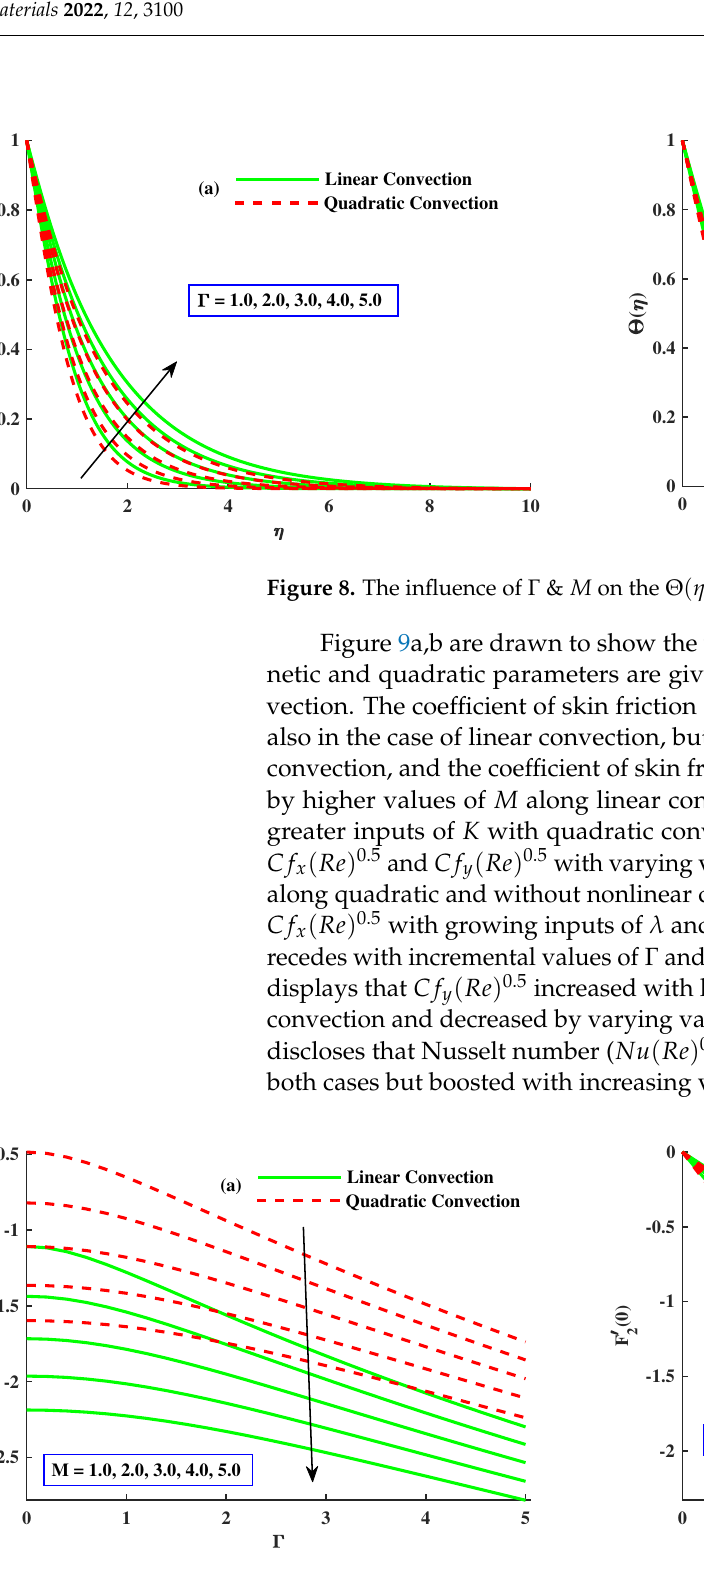
Figure 9. The influence of Γ & M on the Cf x ( Re ) 0.5 and Cf y ( Re ) 0.5